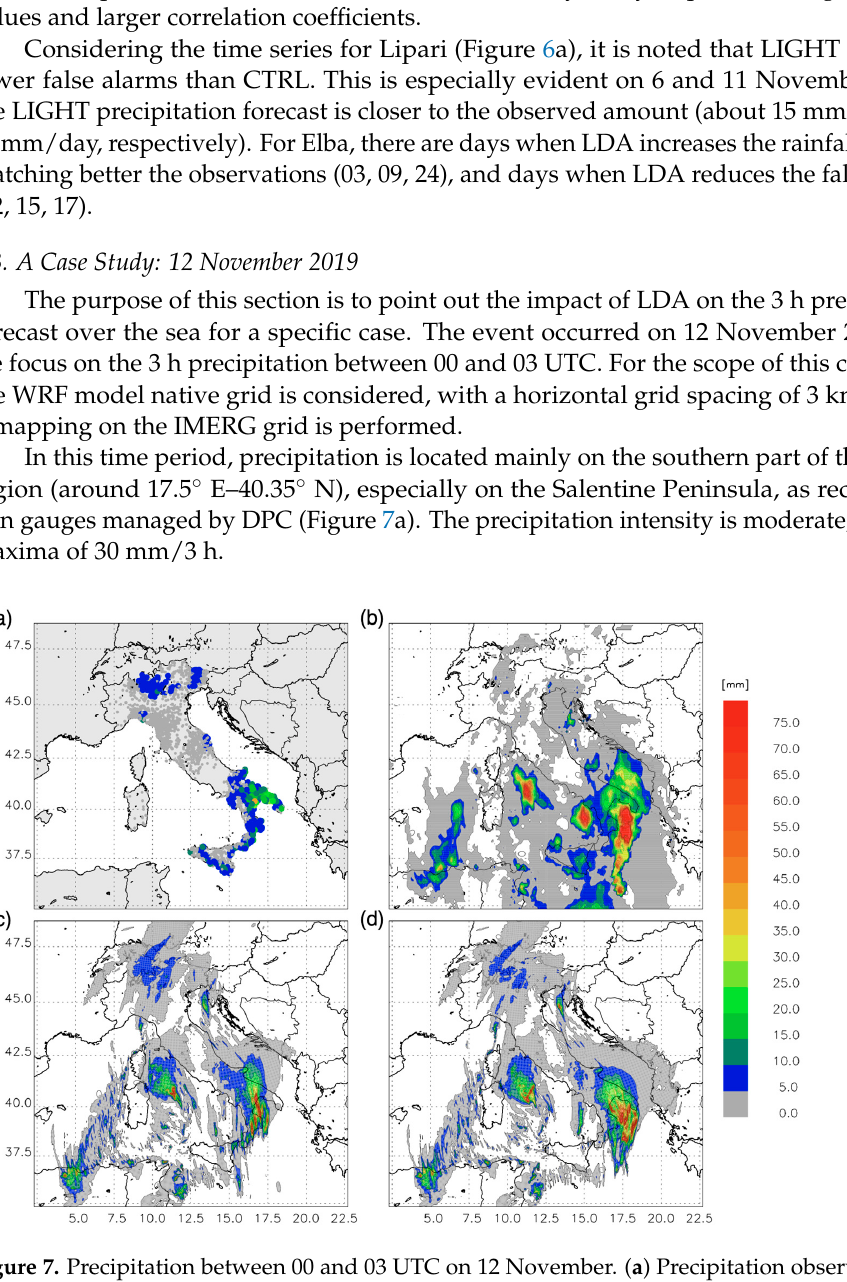
Figure 7. Precipitation between 00 and 03 UTC on 12 November. ( a ) Precipitation observed by the Italian rain gauge network, ( b ) precipitation estimation by GPM-IMERG Final Run, ( c ) precipitation simulated by the CTRL run, and ( d ) precipitation simulated by the LIGHT run.